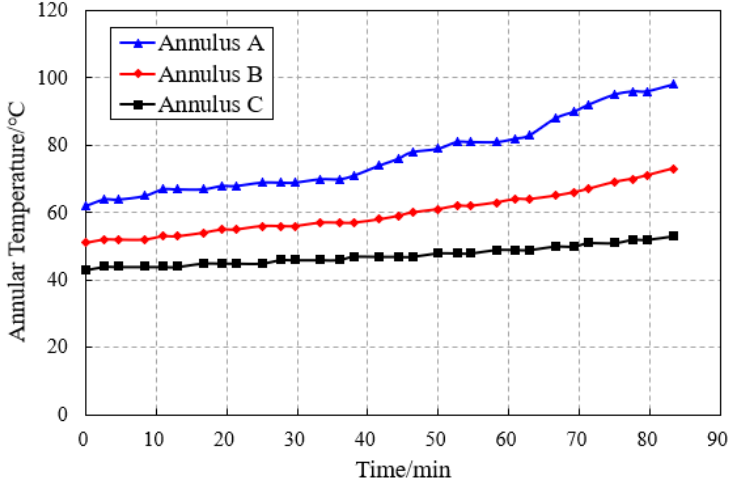
Figure 7. The change of annular temperature with the time.